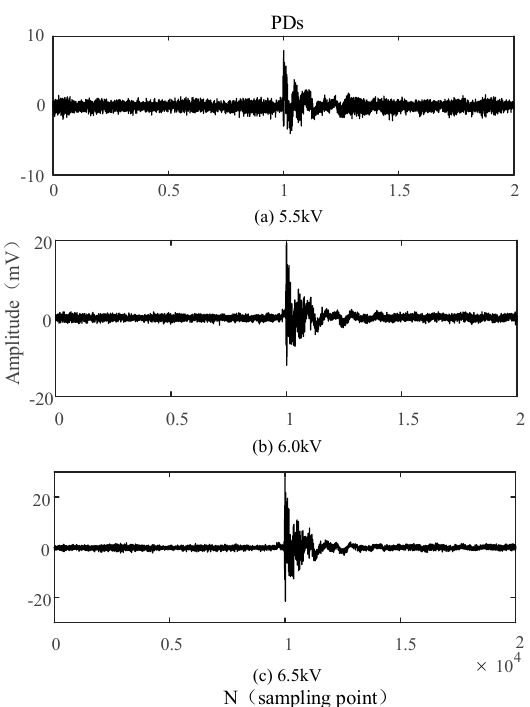
Figure 17. Single PDs detected by the built-in antenna under different voltages.